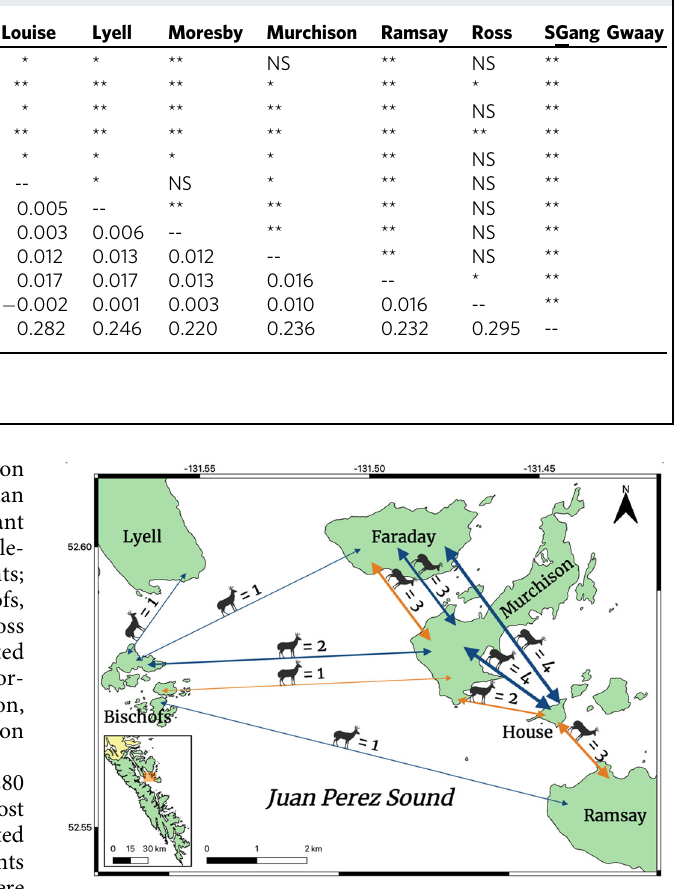
Fig. 3 Inter-island close relatives identi fi ed between Sitka black-tailed deer in Gwaii Haanas. The pairwise kinship analysis was performed using all 181 Sitka black-tailed deer in this study; shown is every detected inter- island fi rst (orange; n = 9) or second (blue; n = 16) order relative pair, each within Juan Perez Sound. The number of related deer pairs found between islands is shown above each line, which are weighted accordingly. A locator map is set in the bottom left corner, with the enlarged area highlighted in